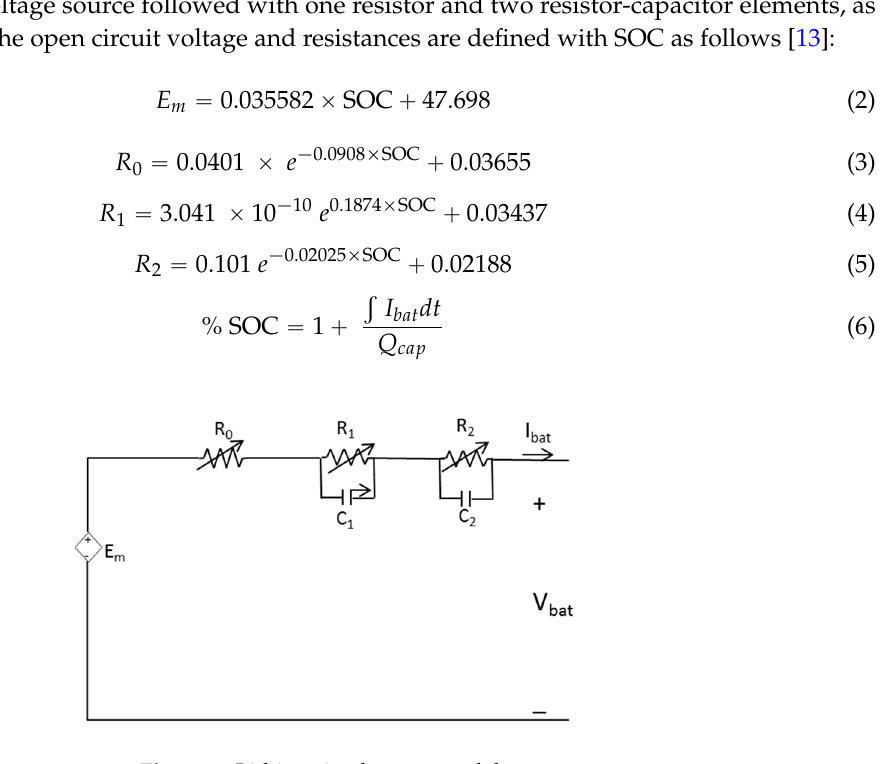
Figure 4. Wind governor transfer function.